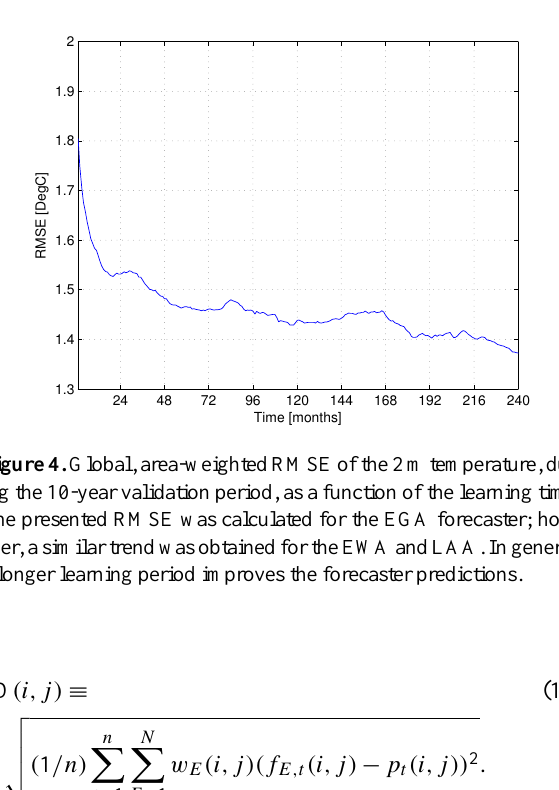
Figure 3. 10-year RMSE of the 2m temperature for three forecasting methods, (a) EWA, (b) EGA, and (c) LAA, and (d) the simple average. The colors represent the RMSE of each grid cell. All the SLA forecasters yield a smaller global RMSE than the simple average. The improvements achieved by the forecasters, compared with the simple average, are more apparent close to the poles and in southwestern America.